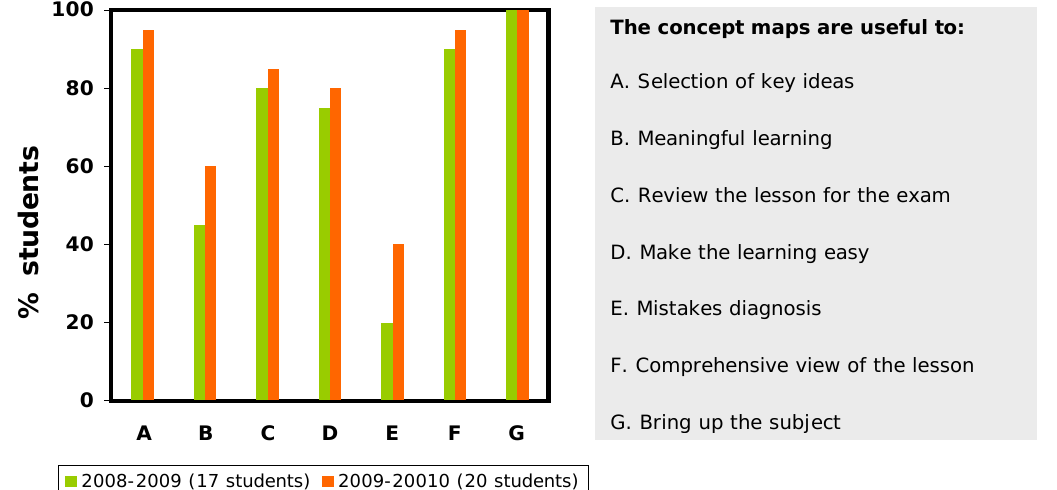
Figure 4. “Results of the opinion poll about the usefulness of the concept maps in the subject Chemical Processes Technology” .